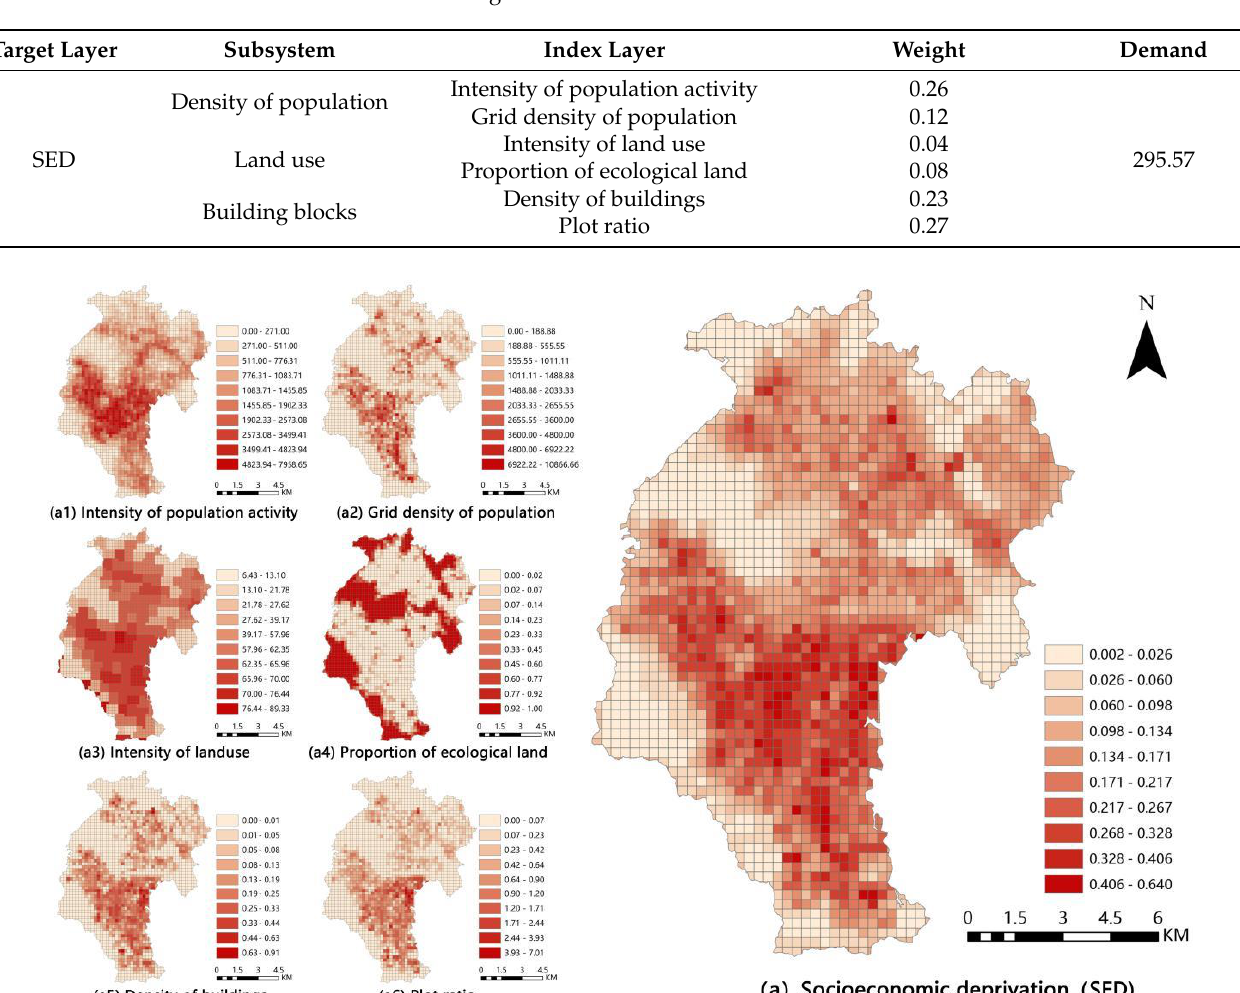
Table 6. Indexes weights and demand of SED.